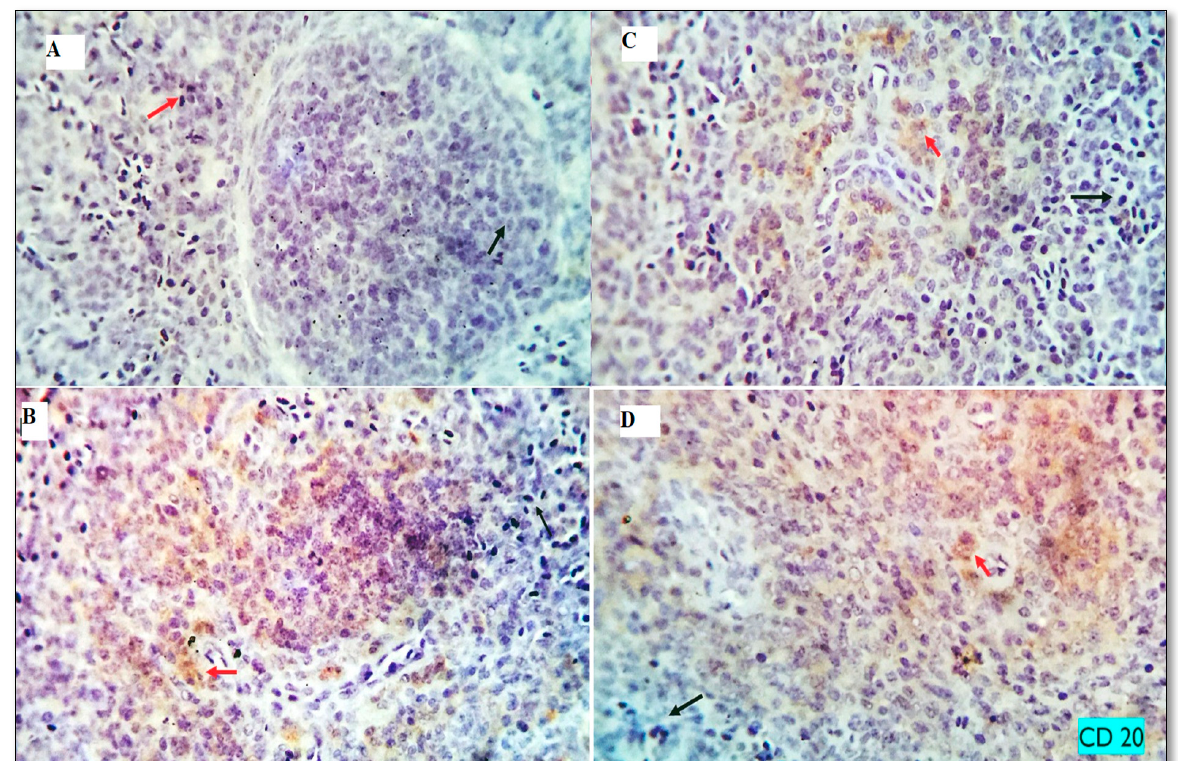
Figure 5. The immunostained positive CD20 cells (red arrows) and negative cells (black arrows) in the spleen of different experimental groups. ( A ): MUR0, ( B ): MUR200, ( C ) MUR400 and ( D ): MUR600.